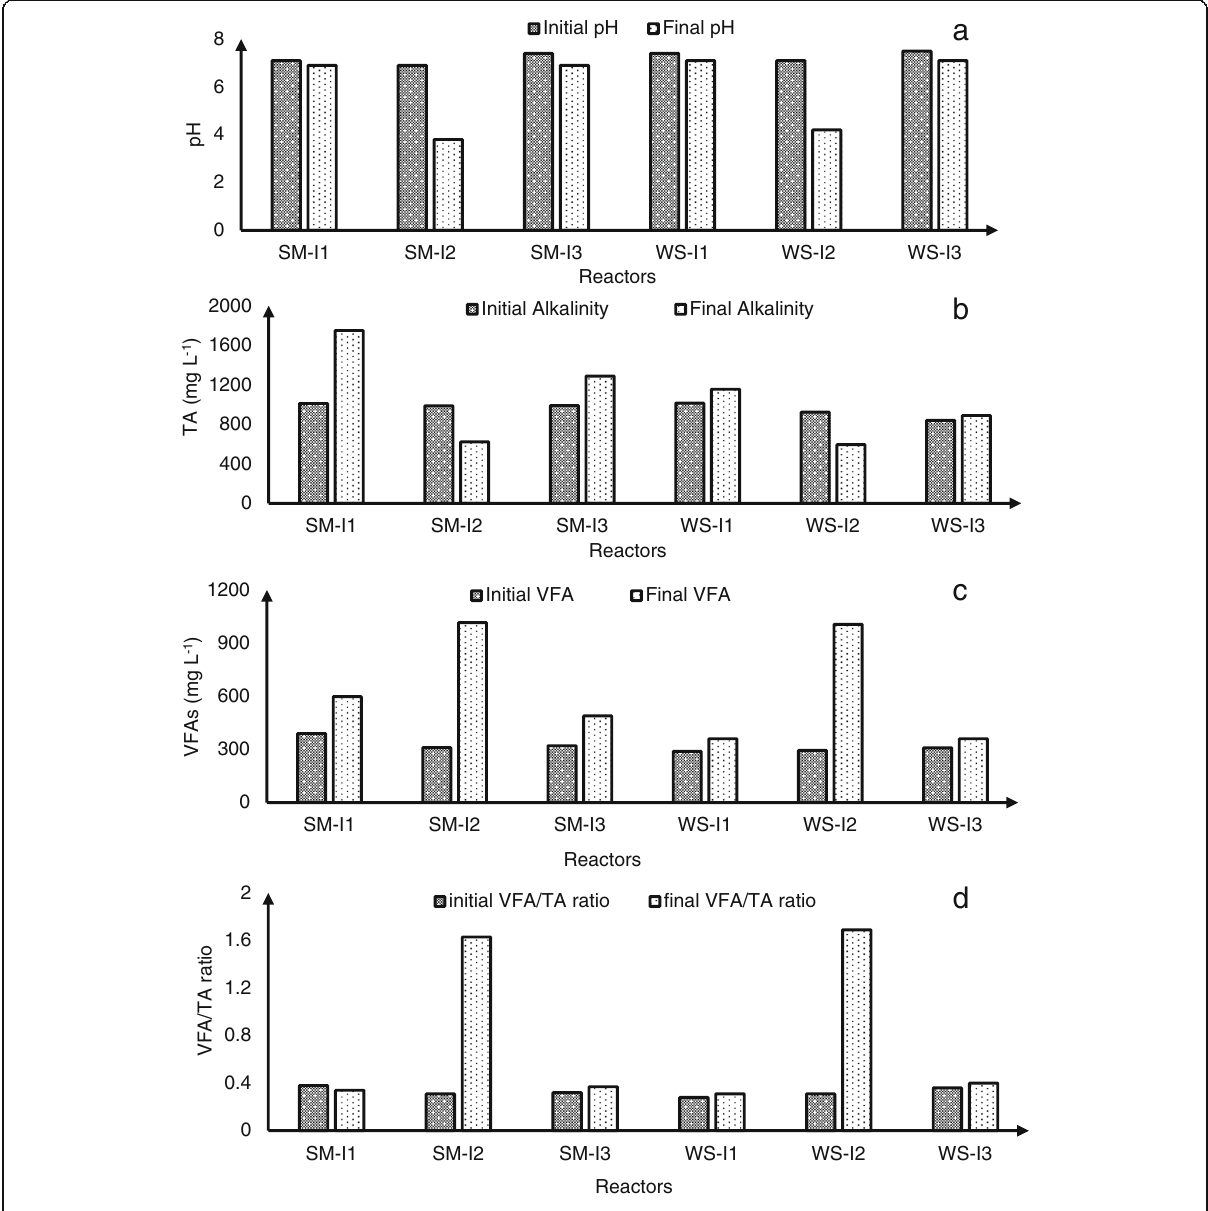
Fig. 2 Buffering capacity and reactor stability parameters ( a ) pH ( b ) TA ( c ) VFAs ( d ) VFA/TA